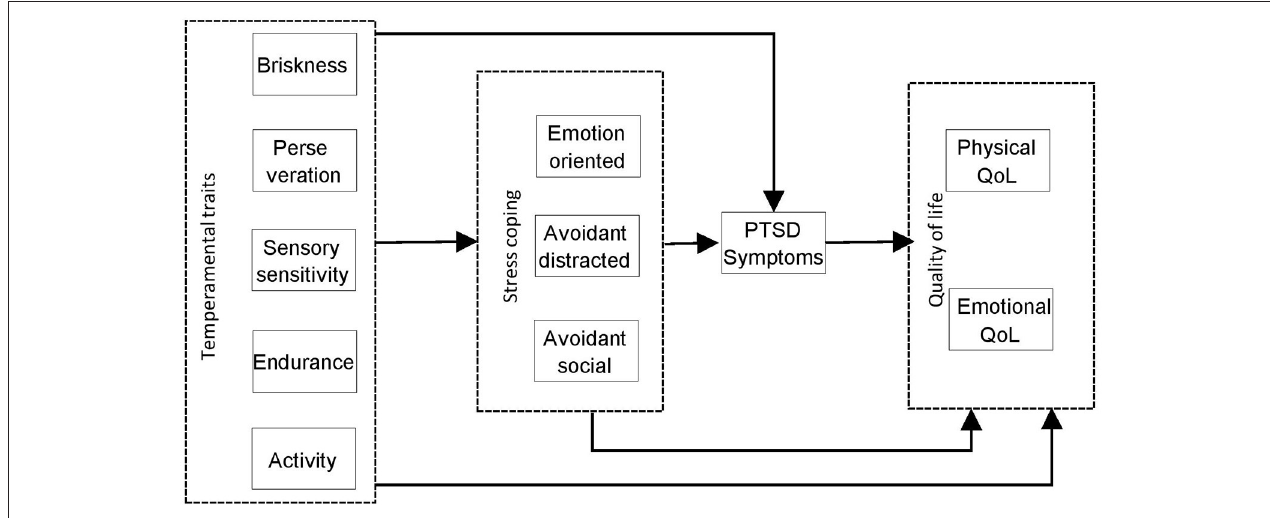
FIGURE 1 | Preliminary model considering relationships between temperamental traits, stress coping styles, PTSD symptoms, and quality of